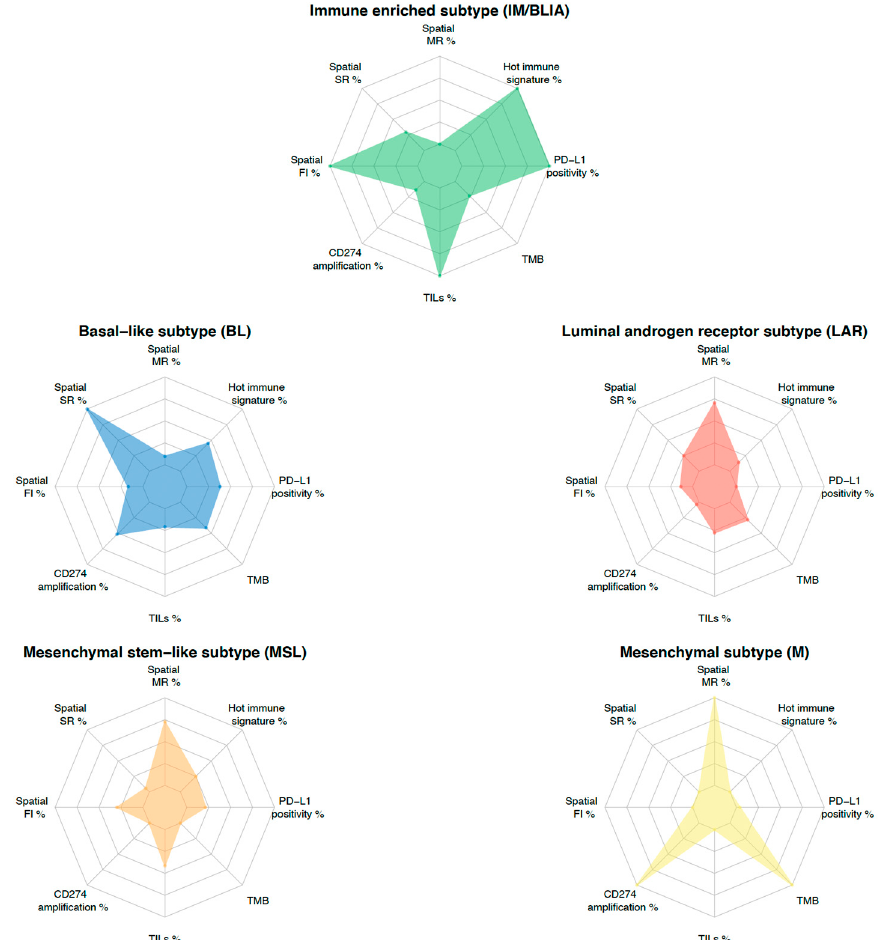
Figure 3. TNBC molecular subtyping immunogram. The radar plot depicts eight parameters that characterize biomarkers potentially predicting a response to ICI-based therapy. Levels of each biomarker are rescaled between minimum (internal ring) and maximum value (external ring) for each parameter across subtypes. The contribution of each biomarker to TNBC molecular subtype is delineated by the connected colored line. Each subtype is represented by a specific color. Abbreviations. FI: fully inflamed, MR: margin-restricted (including immune desert), PD-L1: programmed death-ligand 1, SR: stroma-restricted, TILs: tumor infiltrating lymphocytes, TMB: tumor mutational burden (mut/Mb).